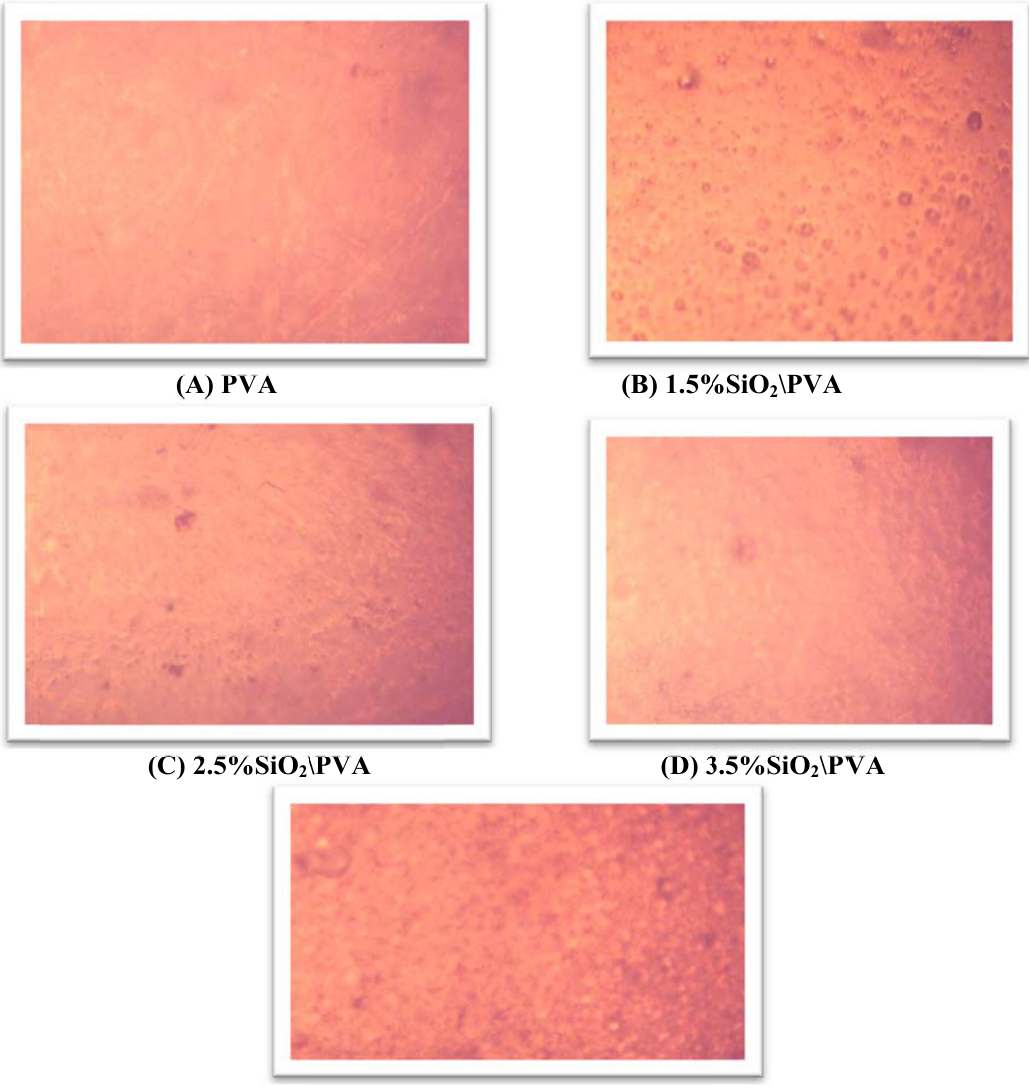
Fig. g.1: Optical